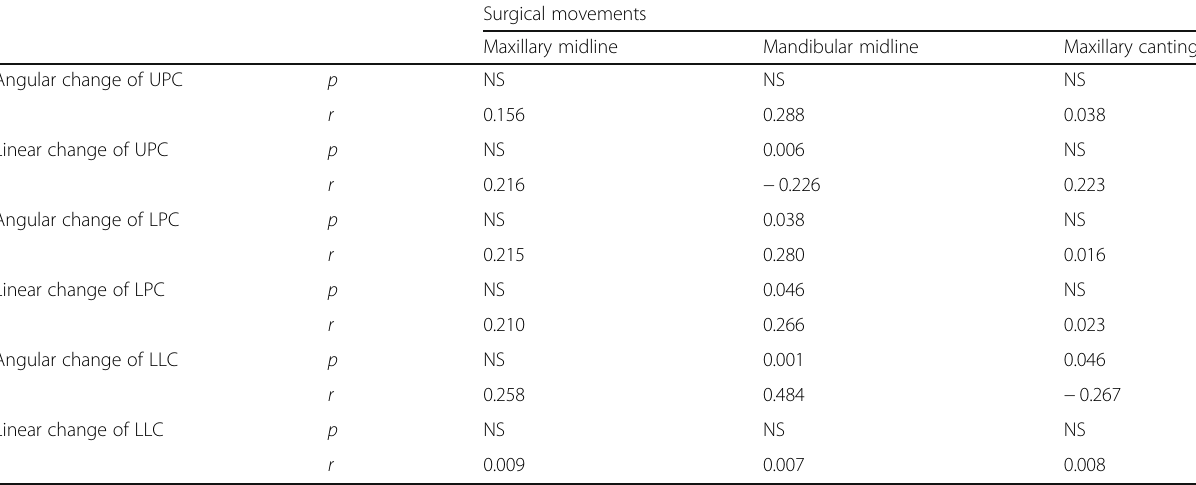
Table 3 Spearman ’ s correlation between surgical movements and changes of the upper philtrum center (UPC), lower philtrum center (LPC), and lower lip center